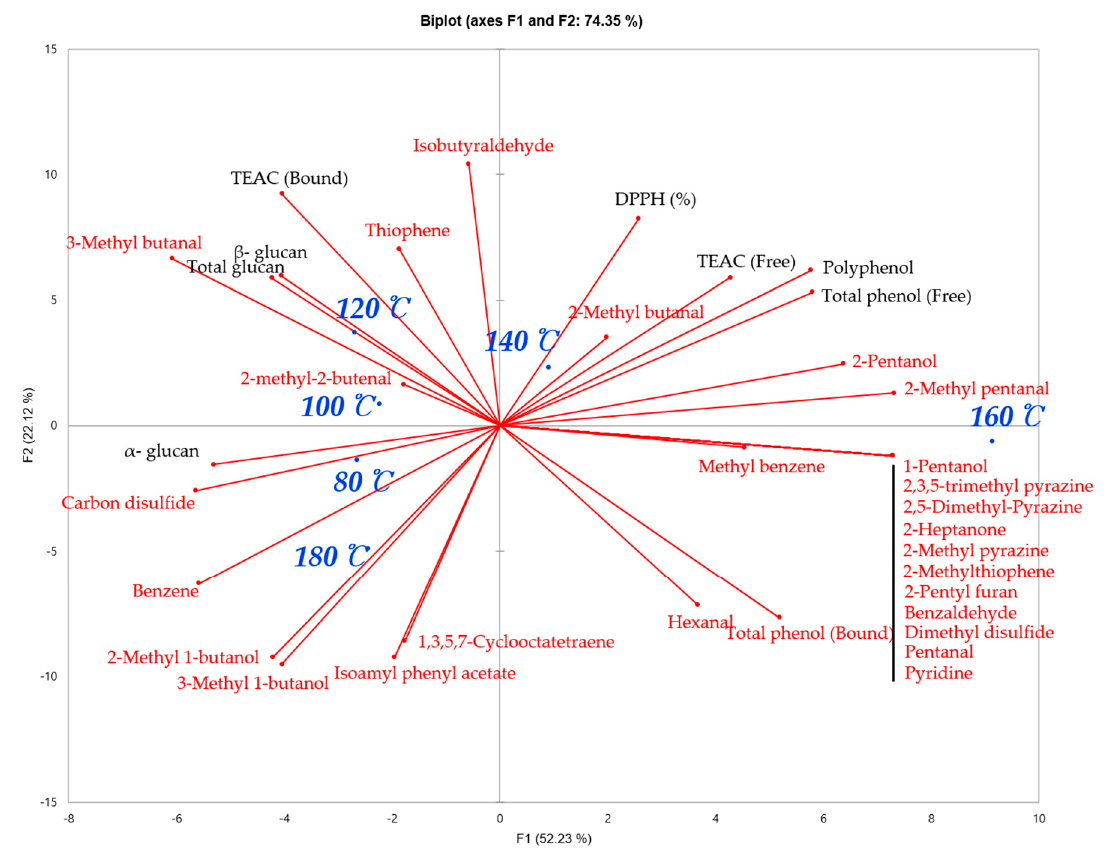
Figure 2. Principal Component Analysis Biplot on antioxidant, β -glucan and volatile flavor profiles of shiitake mushroom roasted in six different temperatures. 80 °C represents shiitake mushroom roasted at 80 °C; 100 °C represents shiitake mushroom roasted at 100 °C; 120 °C represents shiitake mushroom roasted at 120 °C; 140 °C represents shiitake mushroom roasted at 140 °C; 160 °C represents shiitake mushroom roasted at 160 °C.